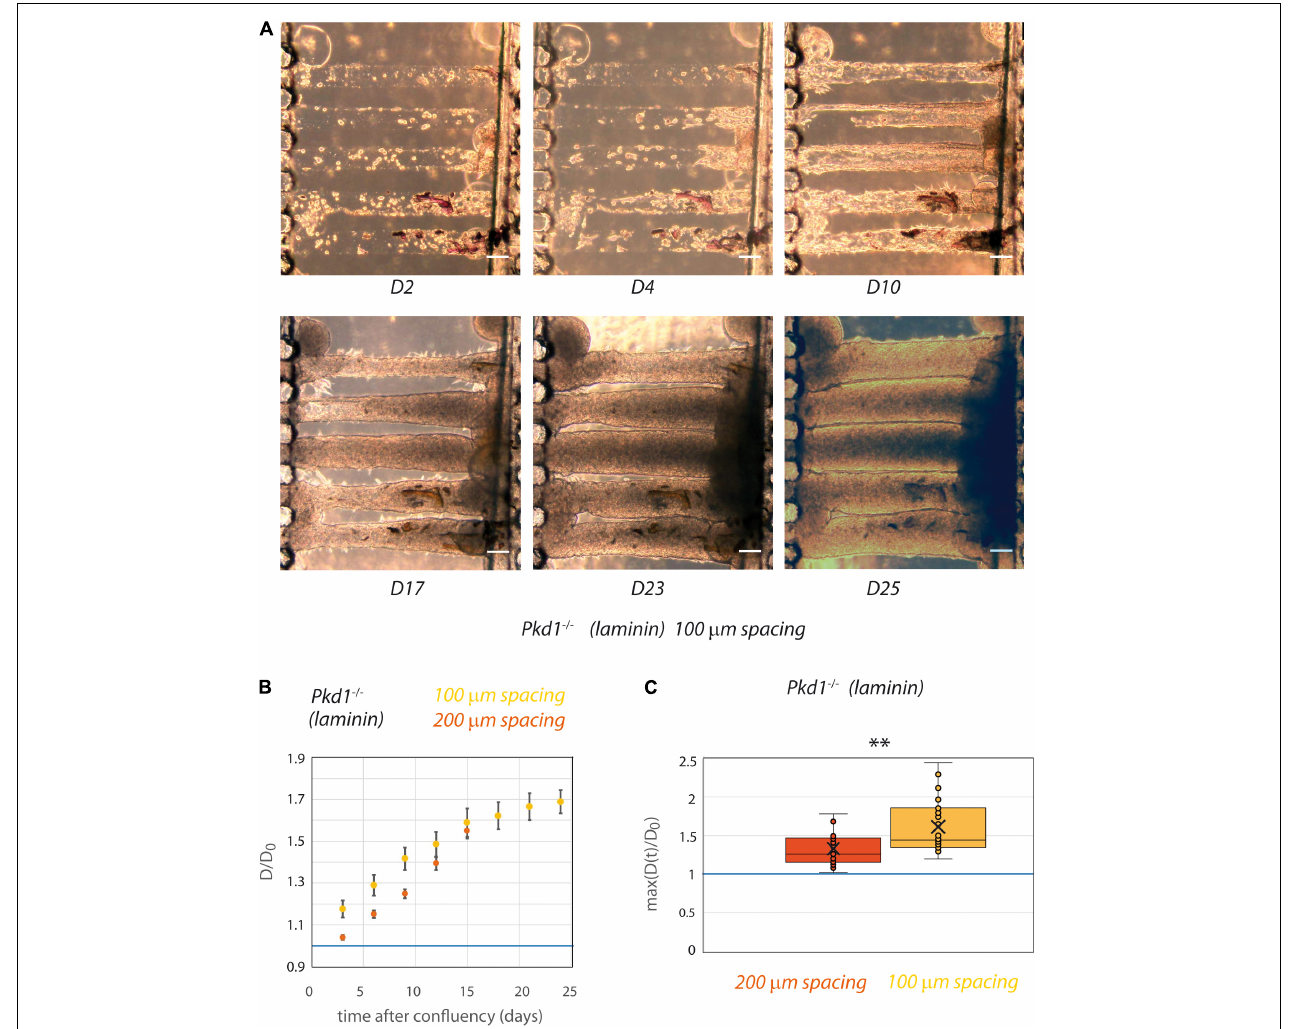
FIGURE 6 | PCT Pkd1 -/- tube deformation in chips with 100 µ m spacing. (A) Example of temporal evolution of tubes seeded with Pkd1 -/- cells at days 2, 4, 10, 17, 23, and 25 after seeding. Scale bar:100 µ m. (B,C) The behavior in 100 µ m spacing tubes (yellow) was assessed with laminin coating and compared to the behavior in 200 µ m spacing laminin-coated tubes (red). (B) Kinetic evolution of mean tube diameter normalized by diameter at seeding, in function of the time after tube confluency. A blue horizontal line at D/D 0 = 1, corresponding to no change in diameter, is indicated. Each time point corresponds to 9–26 tubes for 100 µ m spacing, 4–19 tubes for 200 µ m spacing. Error bars: S.E.M. (C) Maximum (over time) of the mean normalized diameter. Points correspond to individual tube values. Central bar, median; cross, mean; box, values between Q1 and Q3 quartiles; error bars, extreme values [between Q1 - 1.5*(Q3 - Q1) and Q3 + 1.5*(Q3 - Q1)]. (B,C) were computed only for tubes having reached full confluency during the observation period. ** indicates statistically significant difference with p =